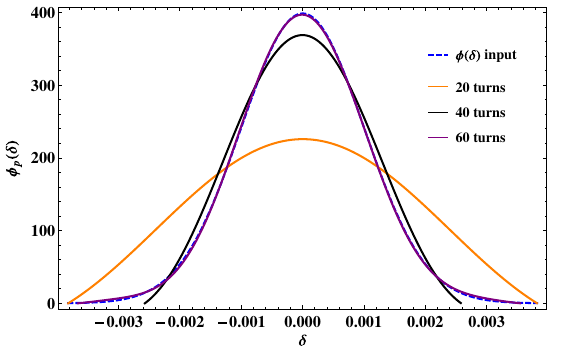
FIG. 6. The reconstructed momentum distribution for trunca- tion at 20, 40, and 60 turns as well as the input form of the momentum distribution, P ð δ Þ .